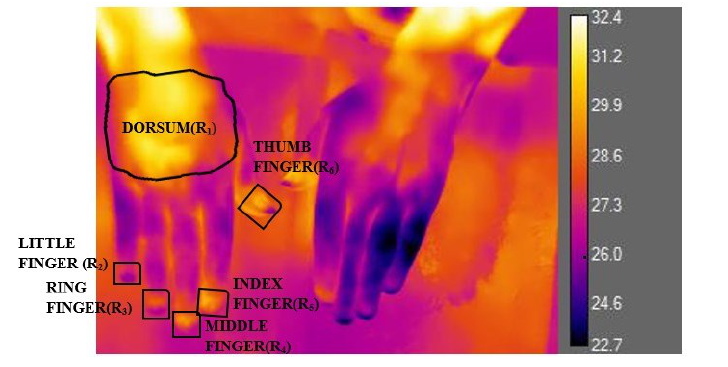
Figure 3. Finding thermal gradients in 6 ROIs to find the